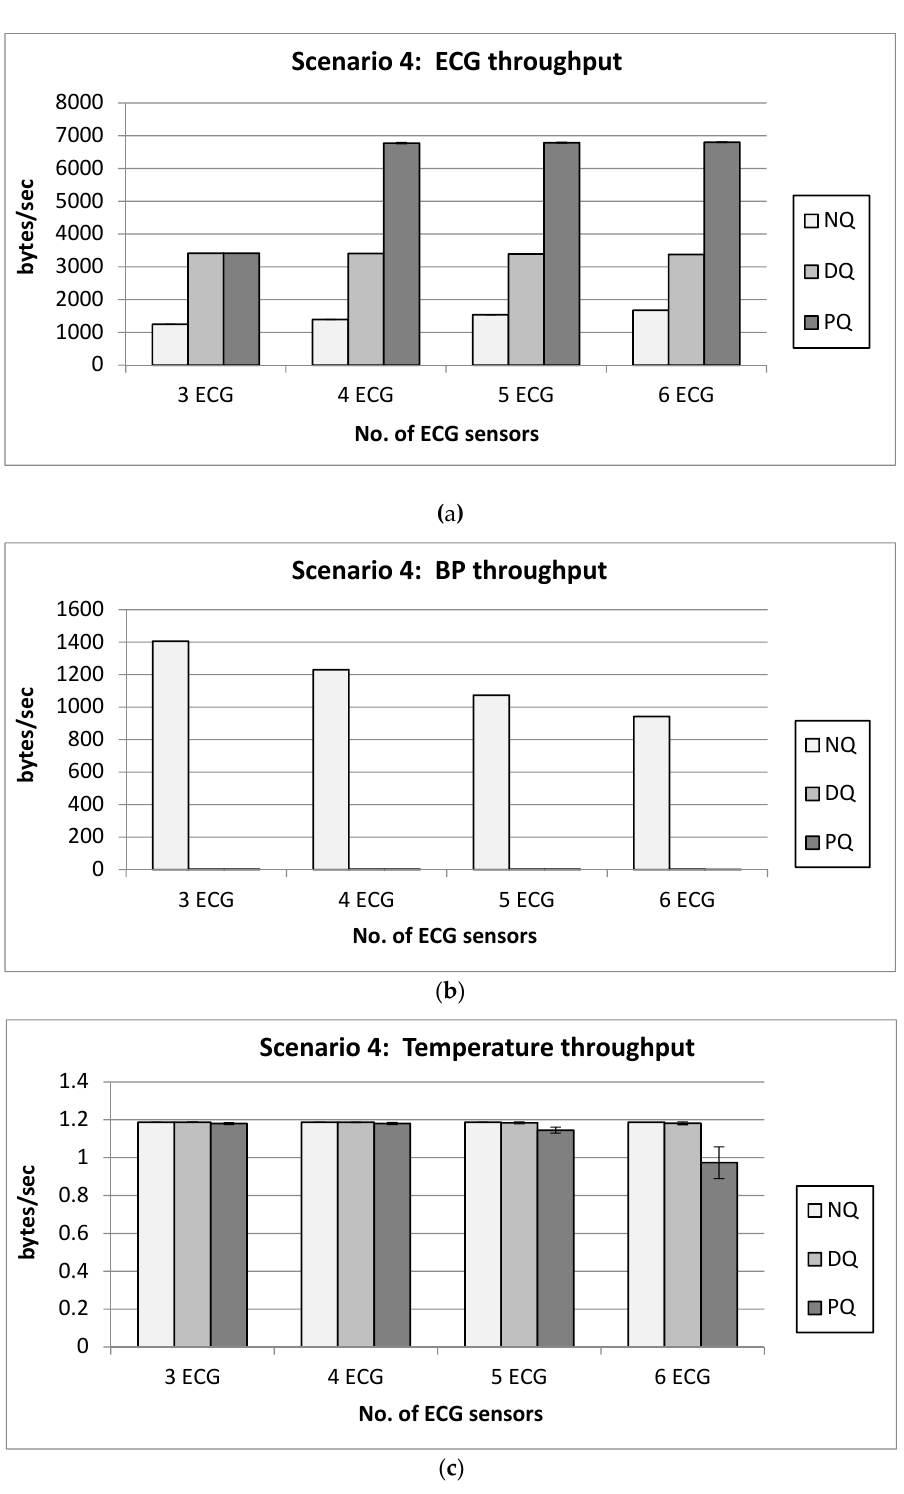
Figure 13. Average throughput results comparison for various data traffic types .